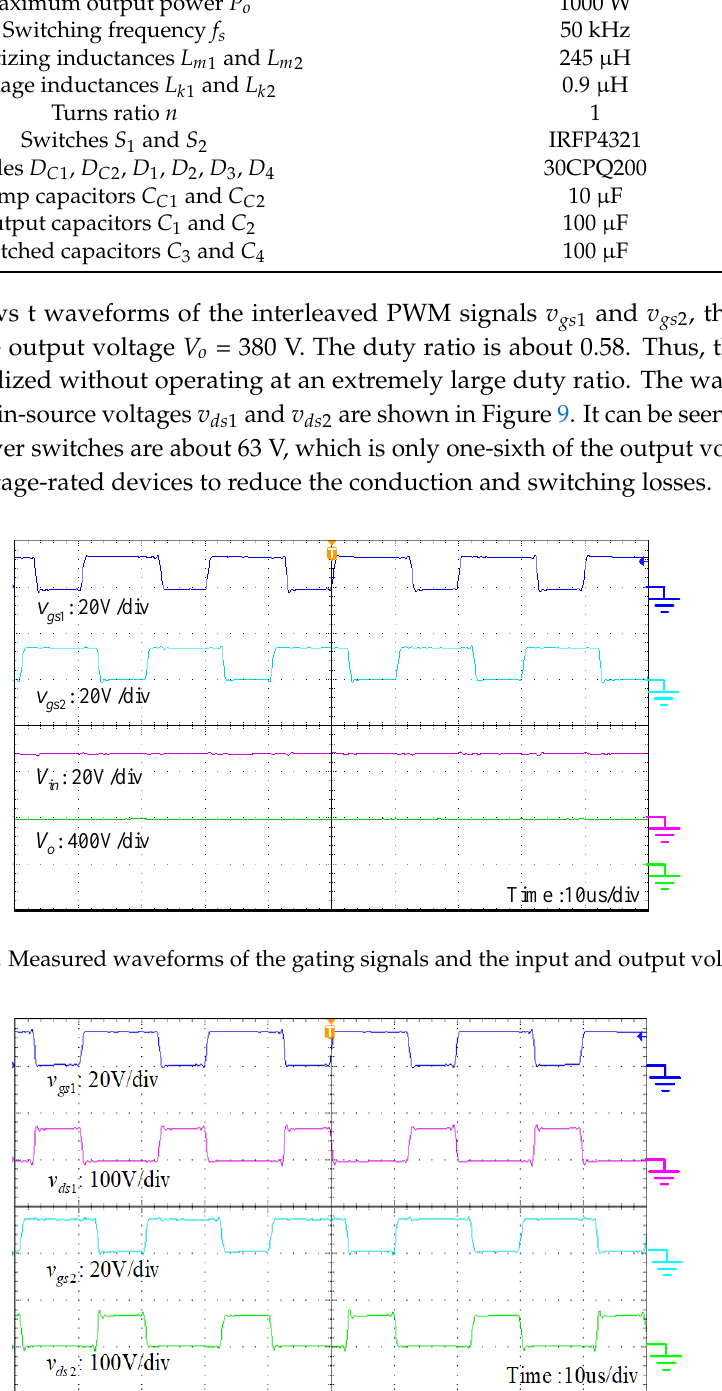
Figure 9. Measured waveforms of the gating signals and the drain-source voltages of power switches.